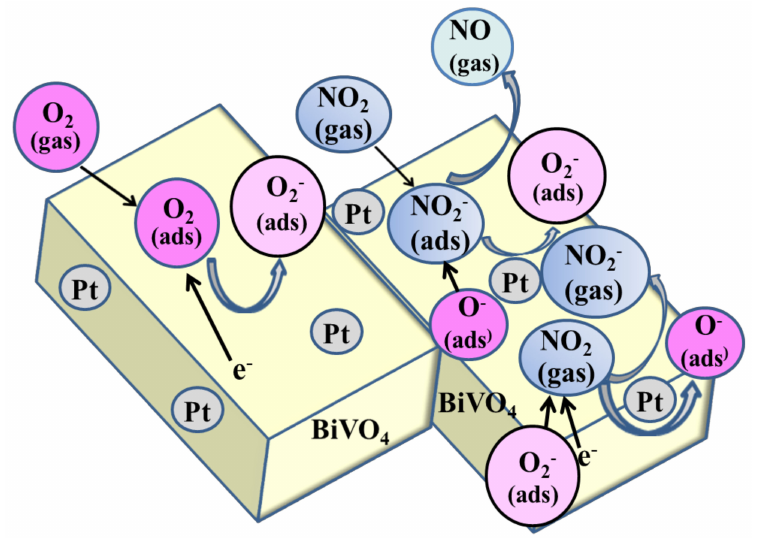
Figure 8. Schematic diagram of NO 2 gas sensing mechanism for Pt/BiVO 4